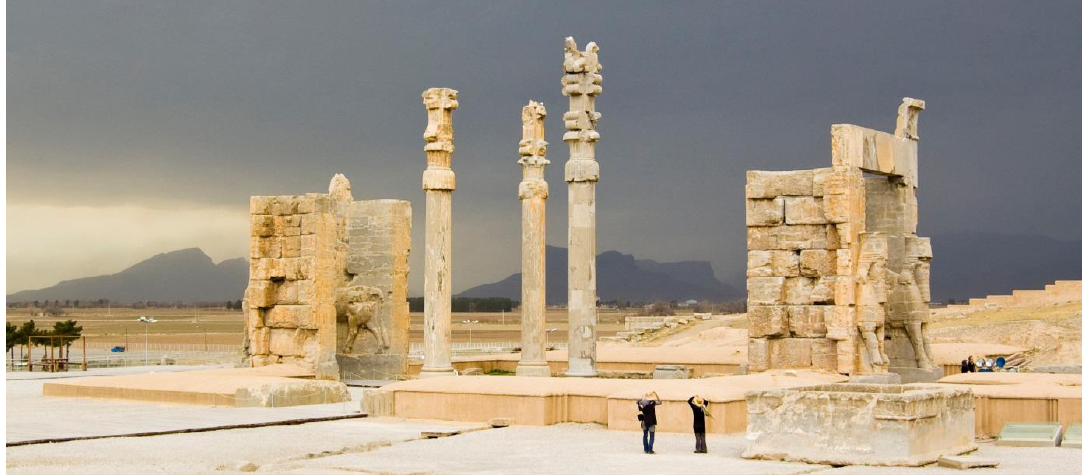
Figure 2. The Gate of All Nations, Contemporary View © David Redhouse photo collection.